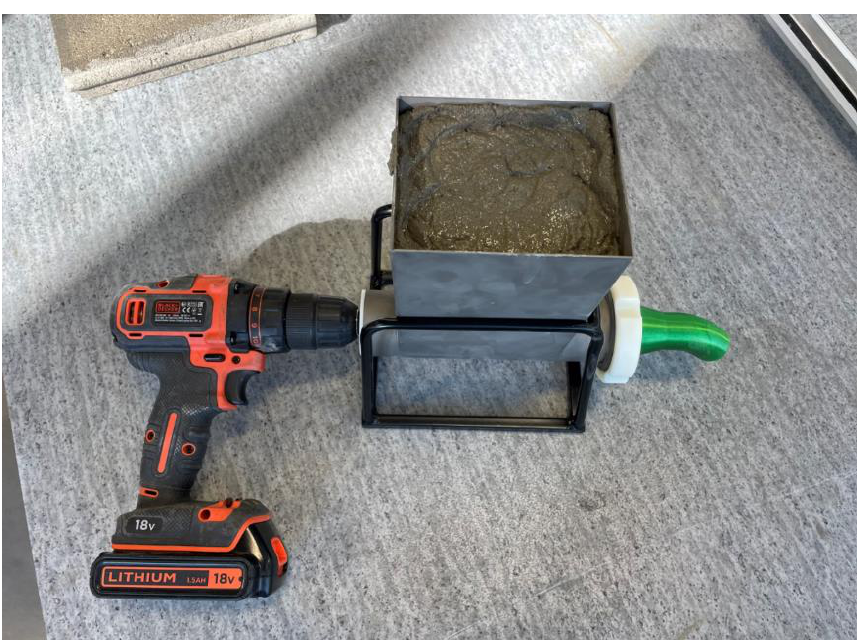
Figure 7. Filled in extrusion equipment with attached power drill. Subsequently, a 40 cm long line is extruded through the entire device onto a solid, moistened surface in layers of the same height (Figure 8).